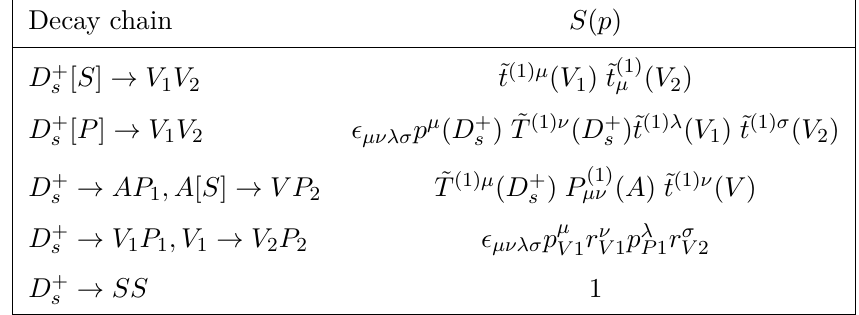
˜ T , have the same